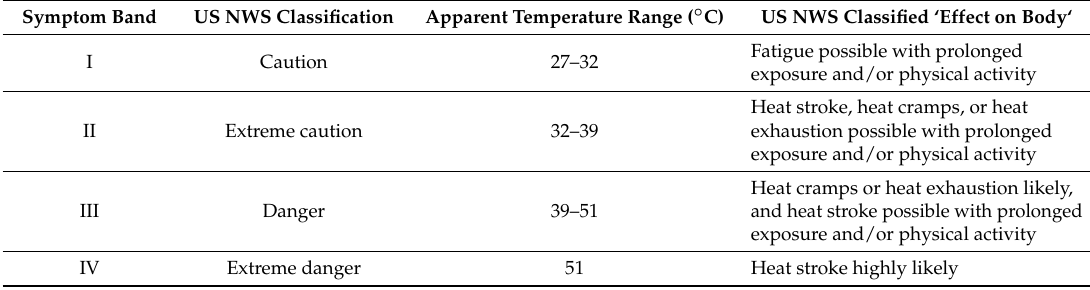
Table 2. Apparent temperature thresholds and potential health impacts at each threshold range [25]. Symptom Band US NWS